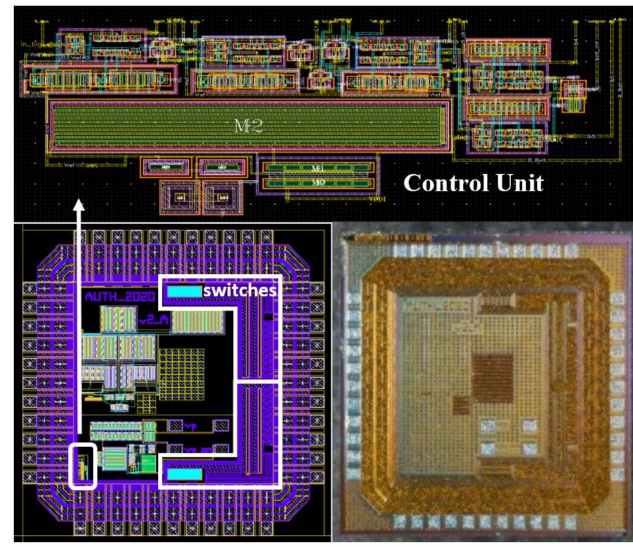
Figure 8. Physical design of the unit and the fabricated die.